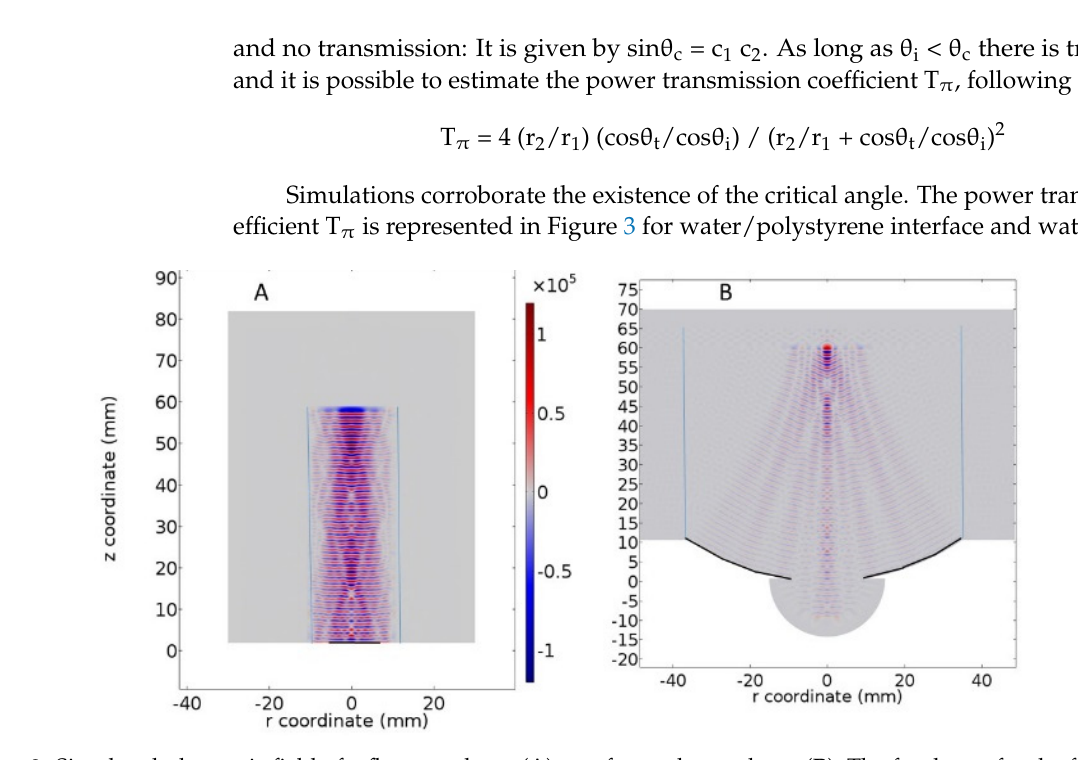
Figure 2. Simulated ultrasonic field of a flat transducer ( A ) or a focused transducer ( B ). The focal spot for the focalized transducer is narrower, but the pressure generated is more intense. The vibrating surface elements of the transducer are depicted in dark bold. The polyethylene walls of the tubes are blue. The focused transducer model was adapted from the COMSOL acoustic modulus library.